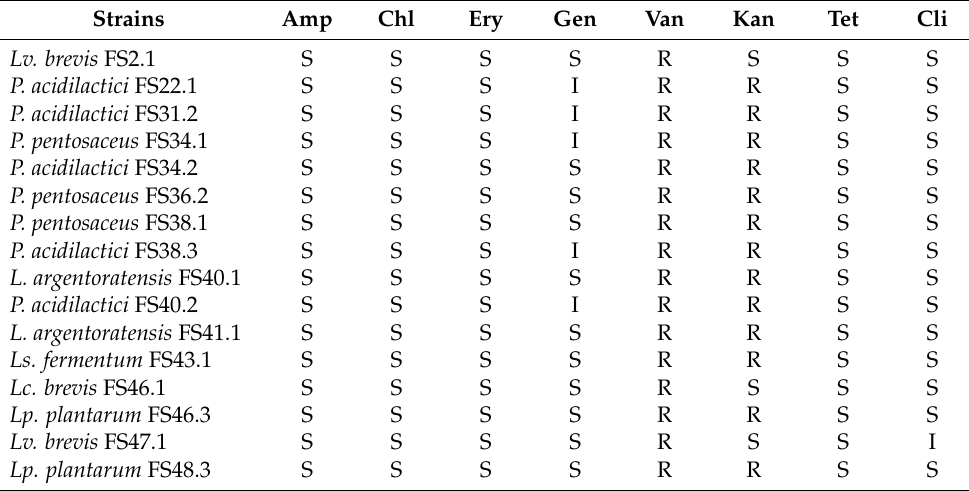
Table 5. Antibiotic susceptibility test of selected XOSs-fermenting LAB.